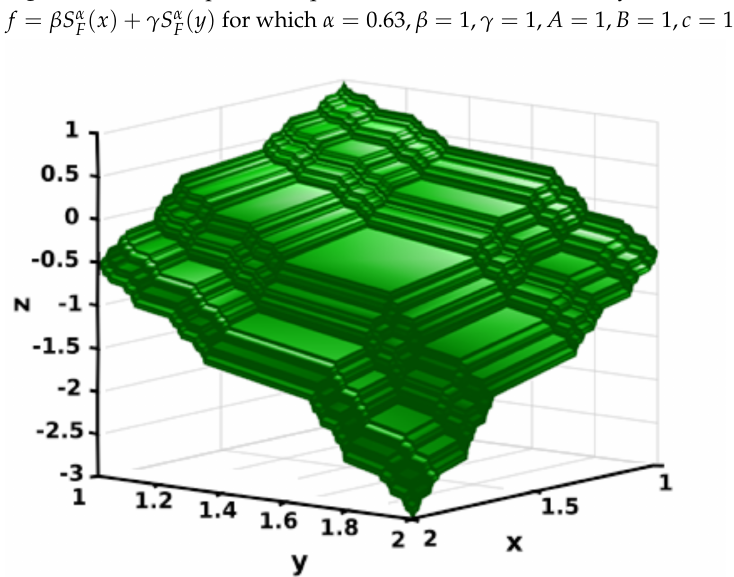
Figure 2. The v component (Equation (23)) is the fluid velocity in the fractal space for the function ( x ) + γ S α ( y ) for which α = 0.63, β = 1, γ = 1, A = 1, B = 1, c = 1. f = β S α F F The graphs of the functions u and v have been given in Figures 3 and